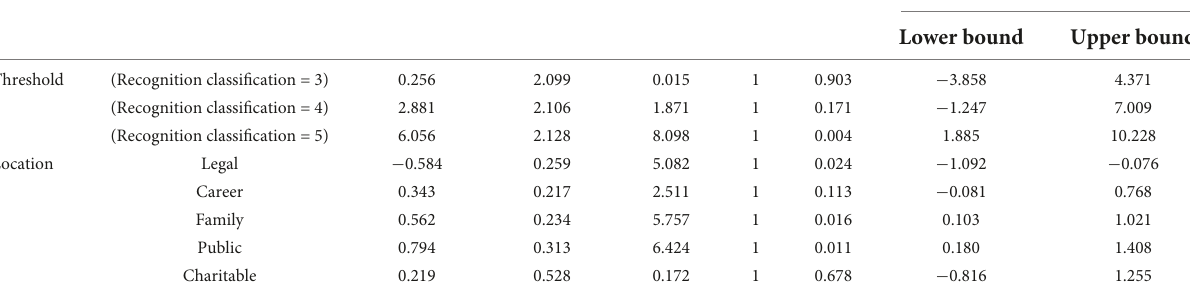
TABLE 9 Parameter estimates. Estimate Std. Error Wald Df Sig. 95% CI